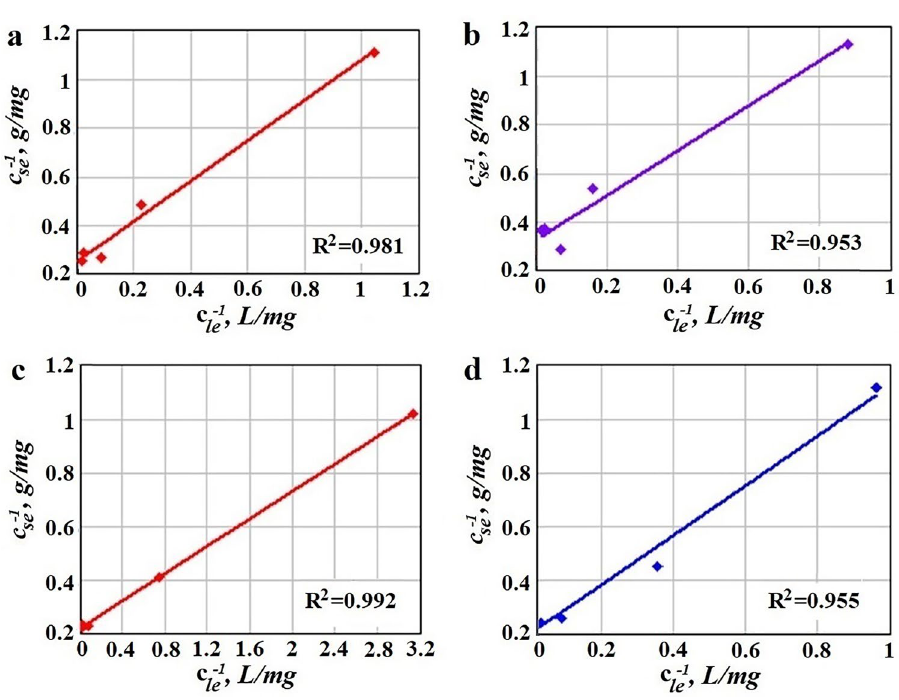
Figure 2. Linear Langmuir isotherm plots (t = 25 °C) for: single silent adsorption ( a ) Pb(II), ( b ) Cd(II) and single US-assisted adsorption ( c ) Pb(II), ( d ) Cd(II); points represent experimental